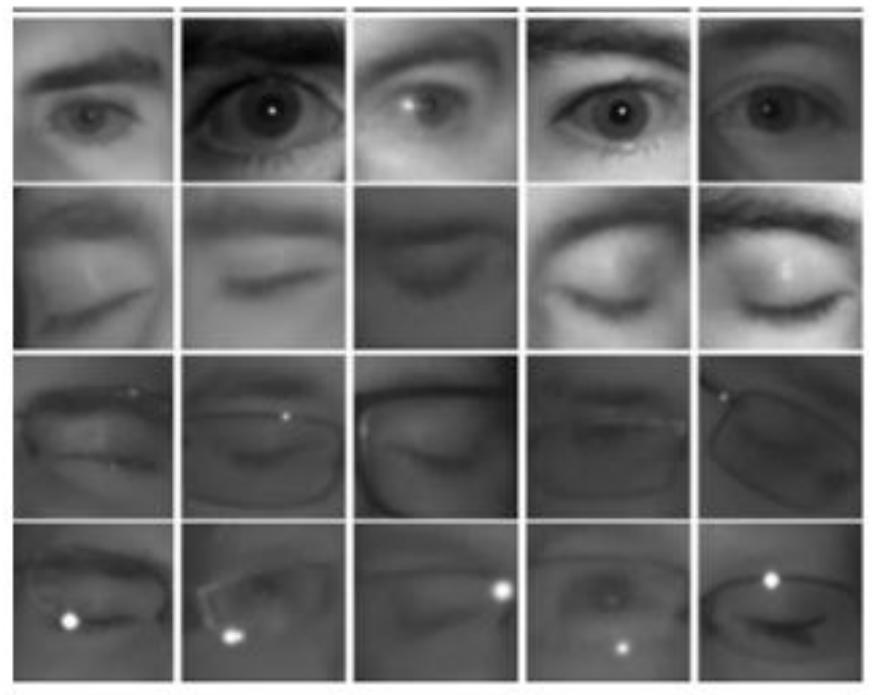
Figure 1. Media Research Lab (MRL) Eye